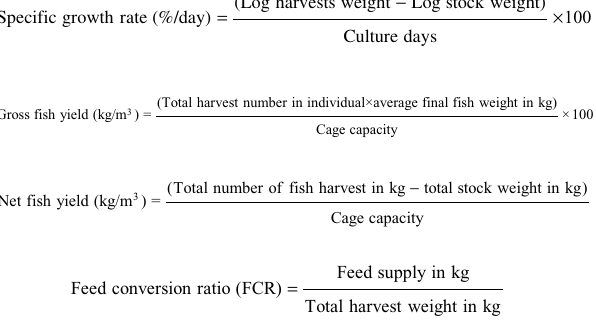
reared in floating cages as shown by C = 0.1339 × FS − 37.238 (with r 2 = 0.988, Figure 2), N = 0.0455 × FS − 8.1604 (with r 2 = 0.996, Figure 3), and P = 0.0048 × FS − 1.117 (with r 2 = 0.991, Figure 4). The feed supply and net fish yield (kg/m 3 /cycle) relationship for the giant gourami reared in float- ing cages was shown by a net fish yield=0.0059×FS+0.7396 (with r 2 =0.9609, Figure